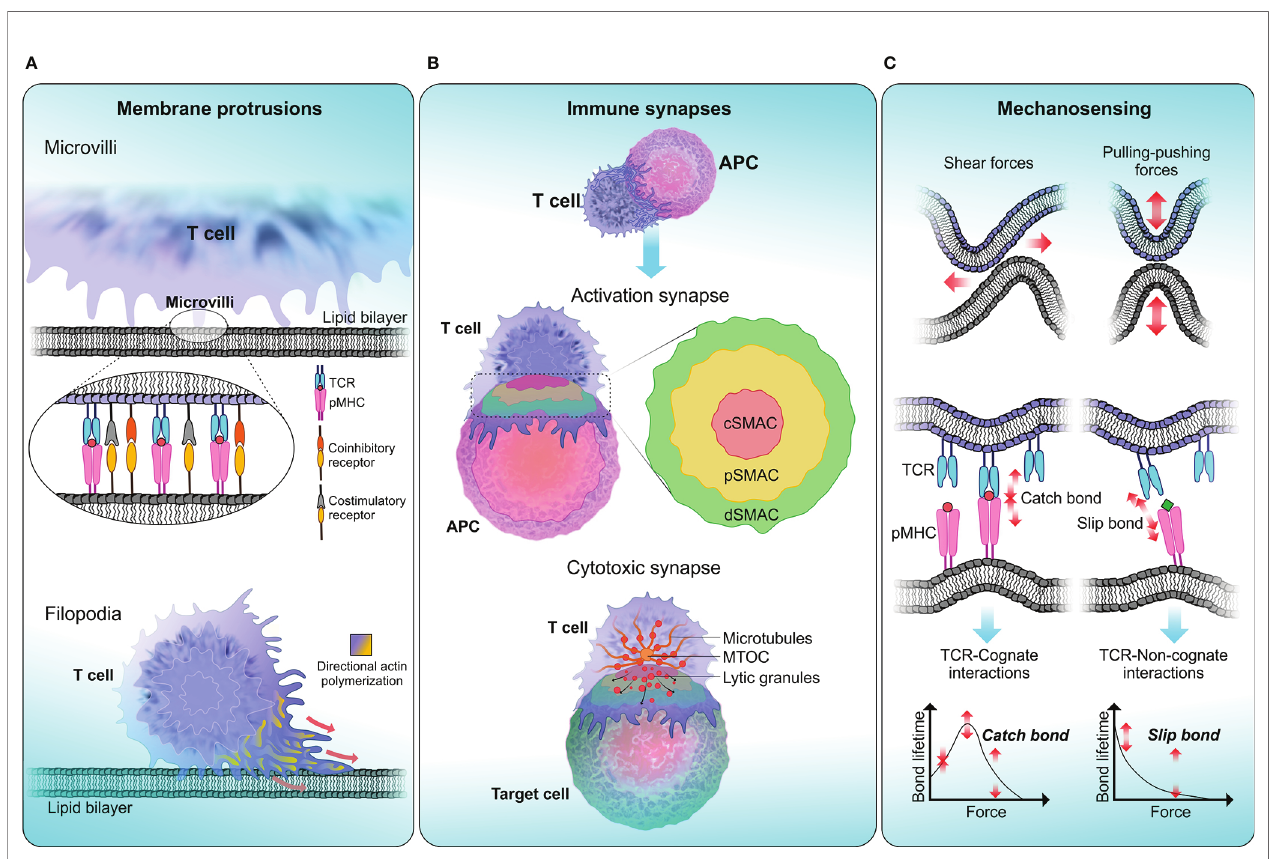
FIGURE 2 | T cell biophysical landscape. (A) Membrane protrusions. T cells continuously form actin-rich membrane protrusions known as fi lopodia or microvilli which help them to sense biophysical properties in the surrounding environment. Microvilli are involved in early T cell activation (173) and where signaling components including TCR and TCR-associated signaling molecules get accumulated (174, 175). The tip of a microvilli is zoomed in to illustrate the accumulation of T cell signaling molecules. Compared to microvilli, fi lopodium membrane projections are larger in size ranging from 10-40 µm in length in different cells (176). The function of fi lopodia is broad including crucial roles in cell-cell adhesion and cell migration (177). (B) Immune synapses. Formation of immune synapses are important steps in T cell activation and executing T cell effector functions through cytotoxicity. When forming activation synapses, signaling receptors (in T cells) and ligands (in APCs) spatially segregate into a bull ’ s eye-like structure forming the supra-molecular activation cluster that is separated into central (cSMAC — red), peripheral (pSMAC — yellow) and distal (dSMAC — green) regions, where each zone preferentially recruit different signaling receptors to initiate T cell signaling. Cytotoxic synapses are formed when a CTL encounters a target cell. Cytotoxic synapses differ from activation synapses in the recruitment of lytic granules to the synaptic cleft with the help of Golgi apparatus and the microtubule organising centre (MTOC). Delivery of lytic granules and exocytosis of granule contents are highly depended on calcium in fl ux. (C) Mechanosensing. T cells are constantly being subjected to mechanical stresses when undergoing kinapse formation with APCs. TCRs display mechanosensing properties by exerting pulling-pushing and shear forces on pMHC molecules on APCs. When a TCR engage with cognate-antigen peptide, a catch bond is formed, which triggers conformational changes in the TCR-CD3 complex and initiate T cell signaling. Conversely, TCR encounter with a non-cognate-antigen peptide results in a slip bond, where an exponential decay of bond lifetime is observed with increasing force. Slip bonds fail to trigger TCR